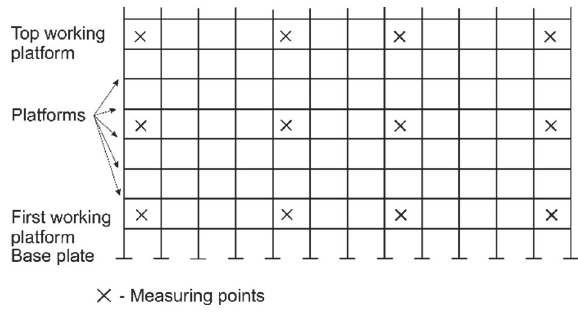
Figure 1. Exemplary arrangement of measurement points